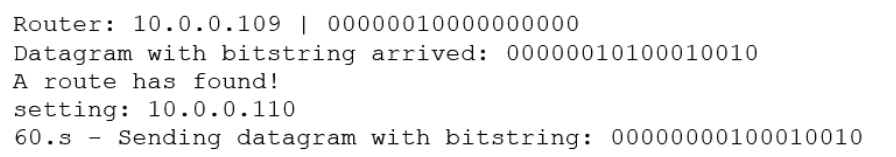
Figure 15. Processing of B-REP packet (R5).